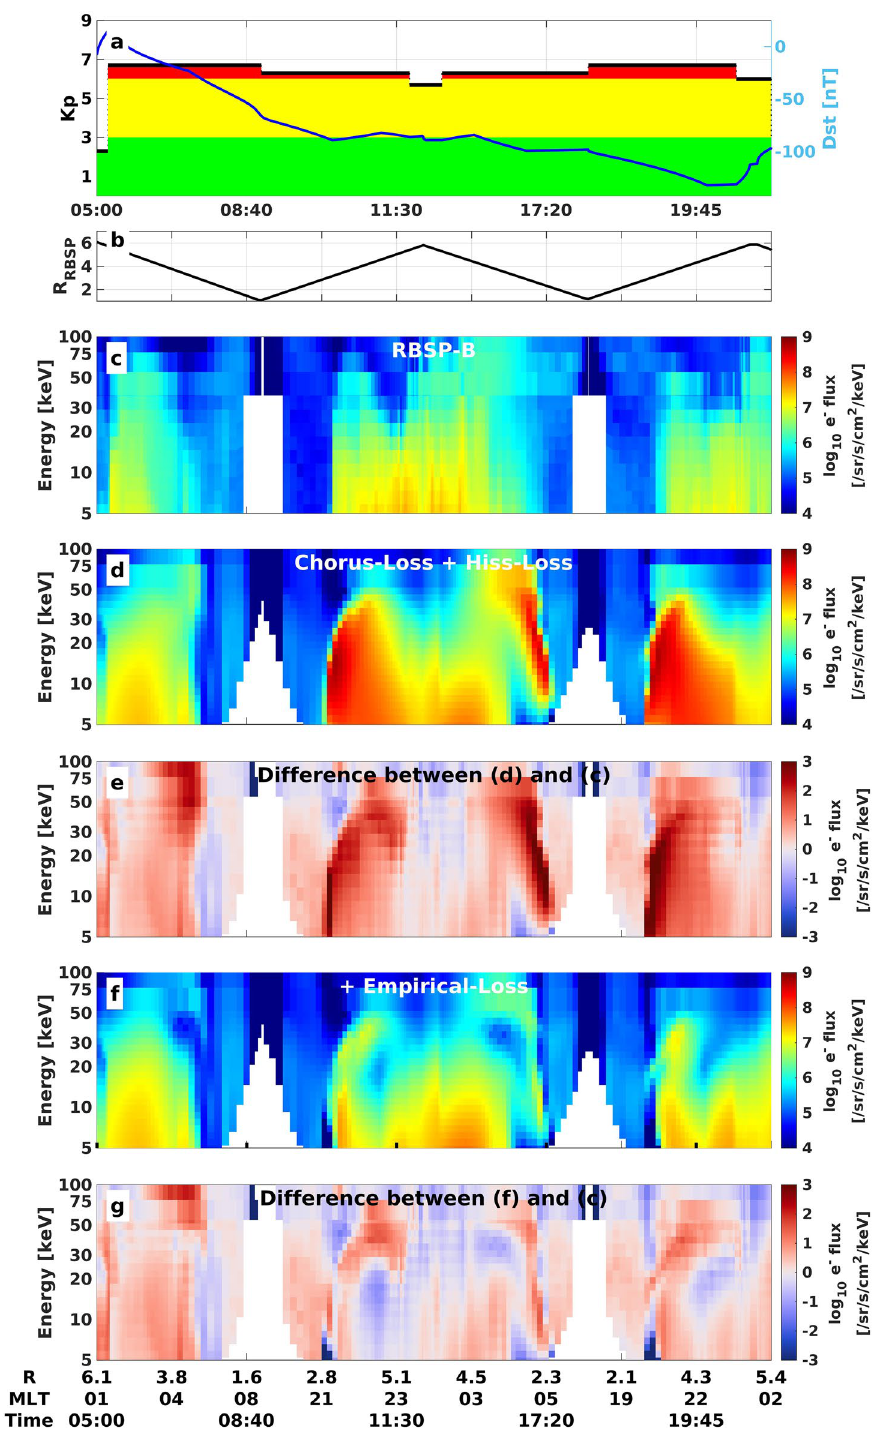
Figure 4. VERB-4D simulation using the derived empirical lifetimes. (a) Kp and Dst timeline. (b) Radial distance of the RBSP-B satellite mapped to the equatorial plane. Electron flux spectrogram at 50 ◦ local pitch- angle (c) observed by the RBSP-B satellite, (d) predicted by VERB-4D using chorus and hiss lifetimes, and (f) predicted by VERB-4D adding the empirical lifetimes. Logarithmic difference between observations and (e) the simulation without empirical lifetimes, (g) with empirical